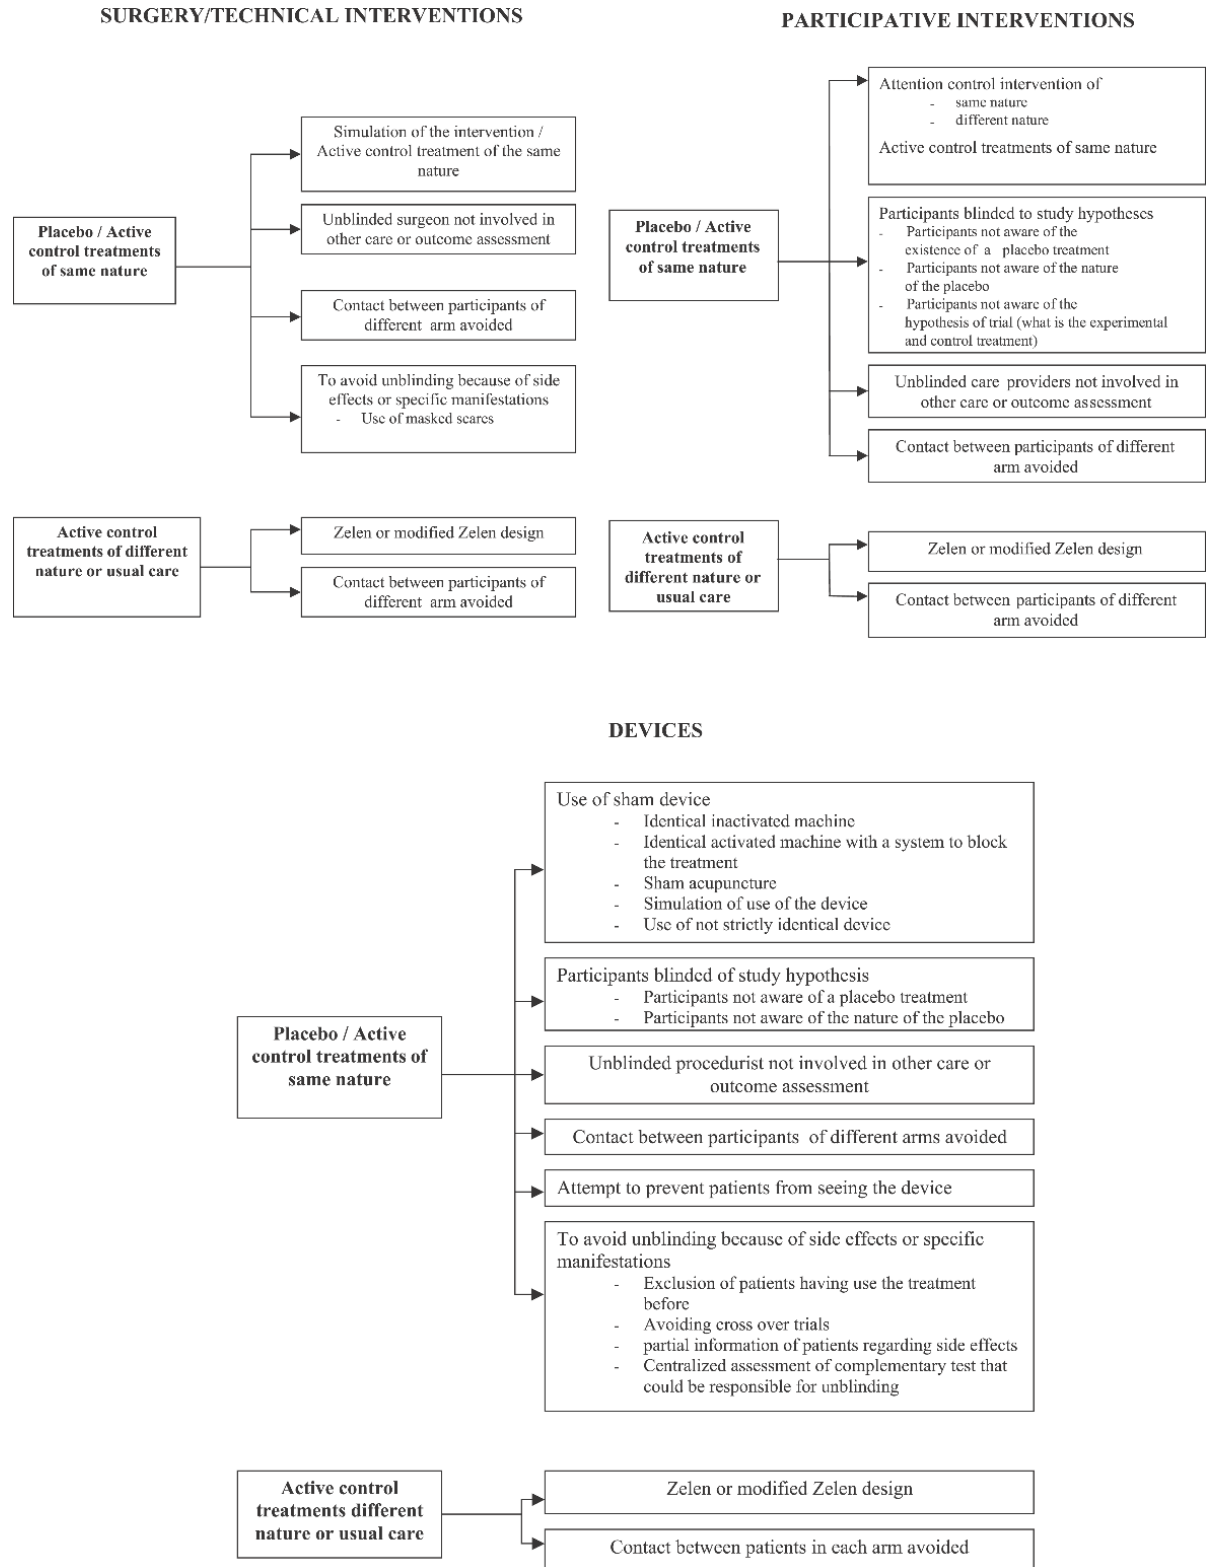
Figure 1. Sham procedure performed according to the category of treatment assessed. Reprinted with permission from ref. [43]. Copyright 2007 Boutron et al. Full text available from https://journals.plos.org/plosmedicine/article?id=10.1371/